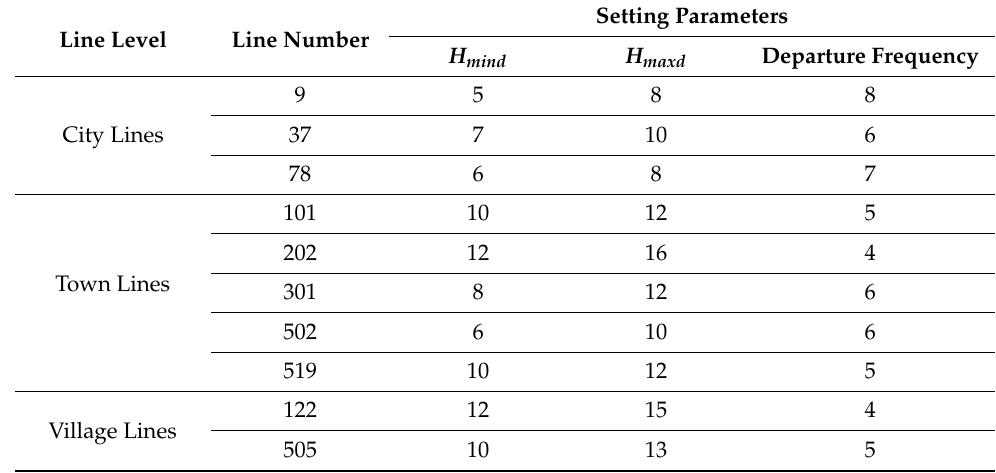
Figure 4. The basic network for Jiangyin. The departure interval and departure frequency for Jiangyin are presented in Table 4. Table 4. Departure interval and departure frequency for Jiangyin.